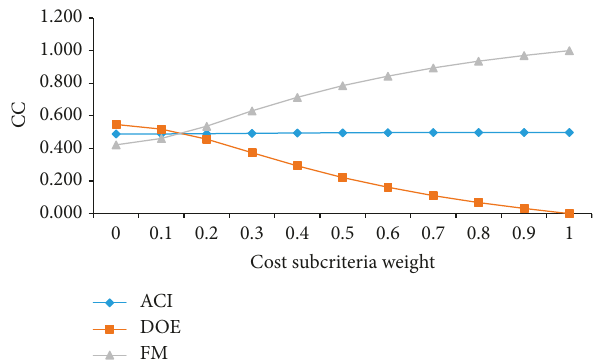
Figure 11: Sensitivity analysis of mix methods with respect to cost